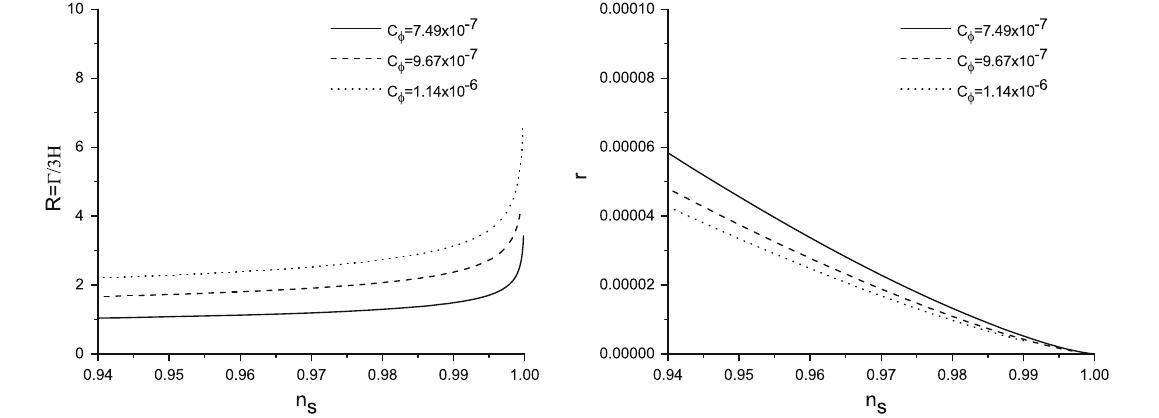
els , the dotted , dashed , and solid lines correspond to the pairs of values ( α = 0.4, V 0 = 1.02 × 10 − 12 ), ( α = 0.8 and V 0 = 1.06 × 10 − 12 ), and ( α = 1.2, V 0 = 1.11 × 10 − 12 ), respectively. In these plots we have